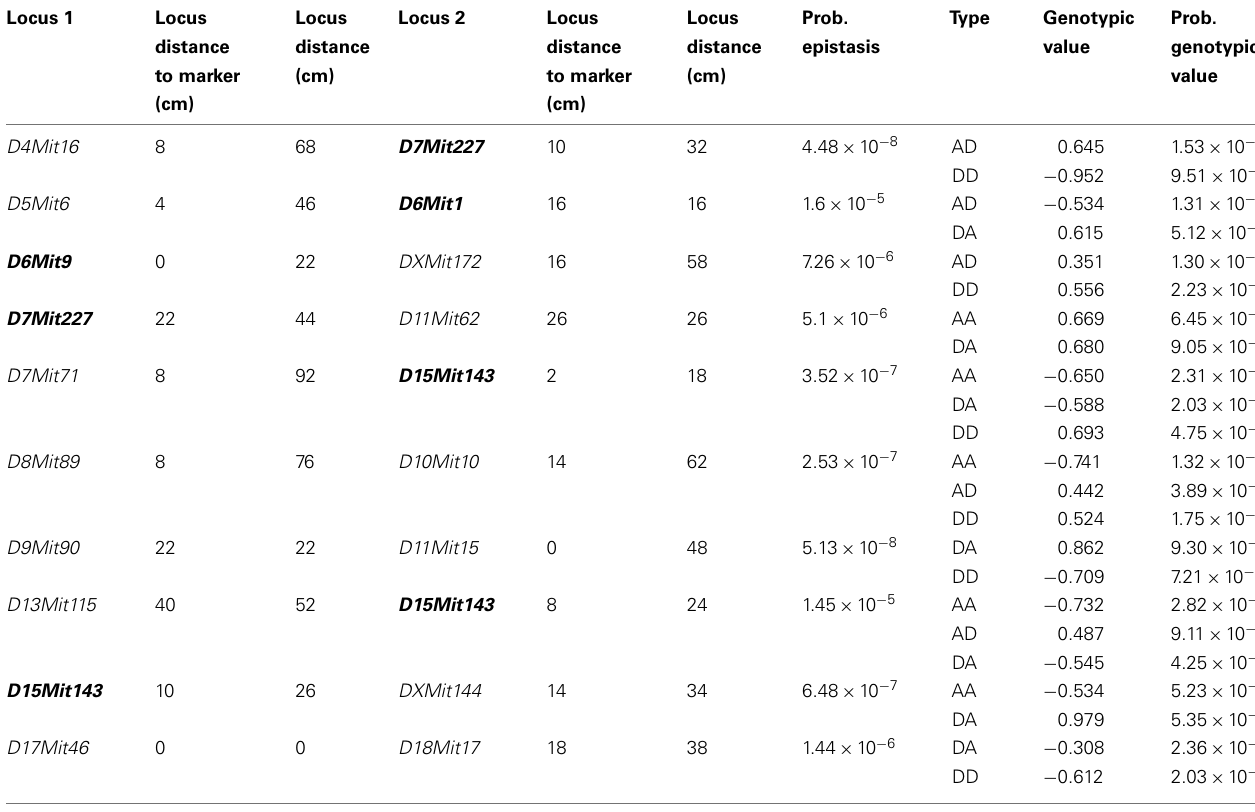
TableA1 | Epistatic QTLs of prepartum nest presence in F 2 females. Locus 1